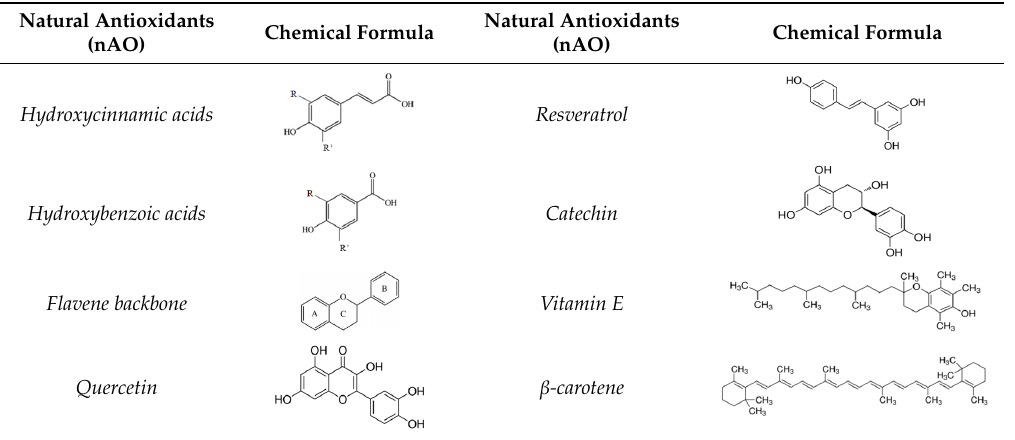
Table 8. Basic chemical structures of most common natural antioxidants [23], Reproduced with permission from Dintcheva NTz, ACS Sustainable Chem. Eng.; published by ACS Publications, 2019 .